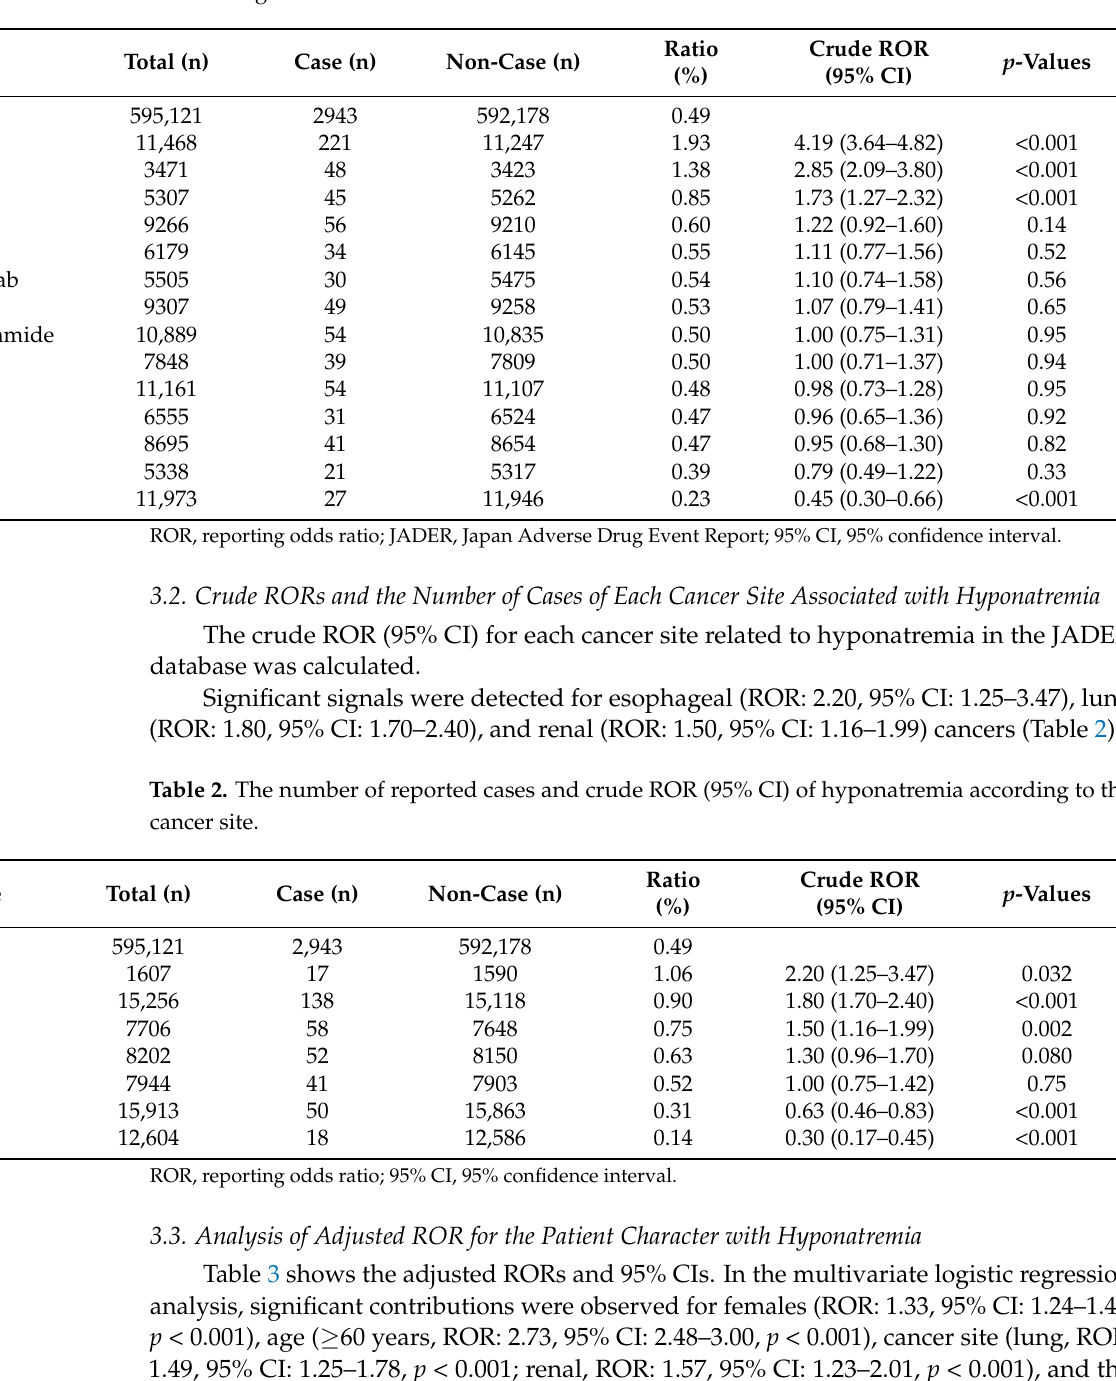
Table 1. The number of reported cases and crude ROR (95% CI) of hyponatremia based on anti- cancer drugs.